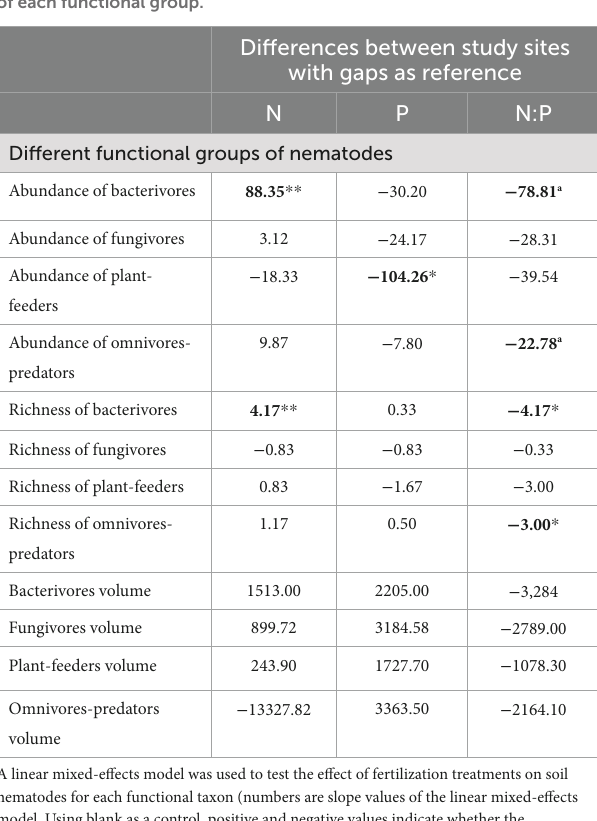
TABLE 3 Effect of fertilization treatments on soil nematode communities of each functional